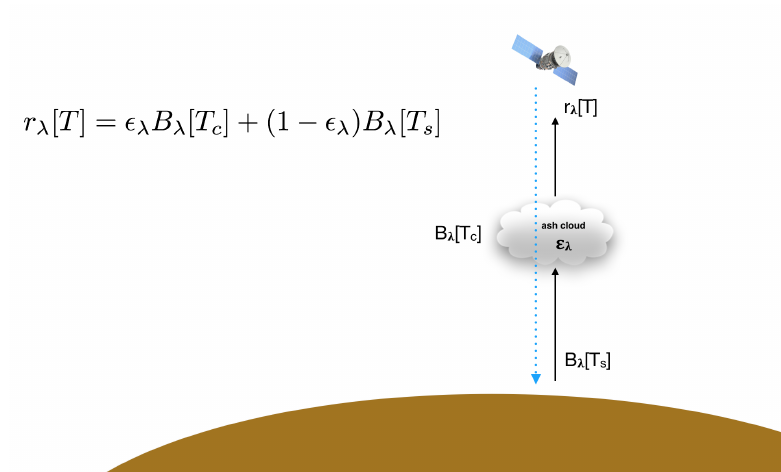
Figure 3. Radiative transfer problem for a cloud embedded in a transparent atmosphere and viewed directly from above by a satellite-borne infrared